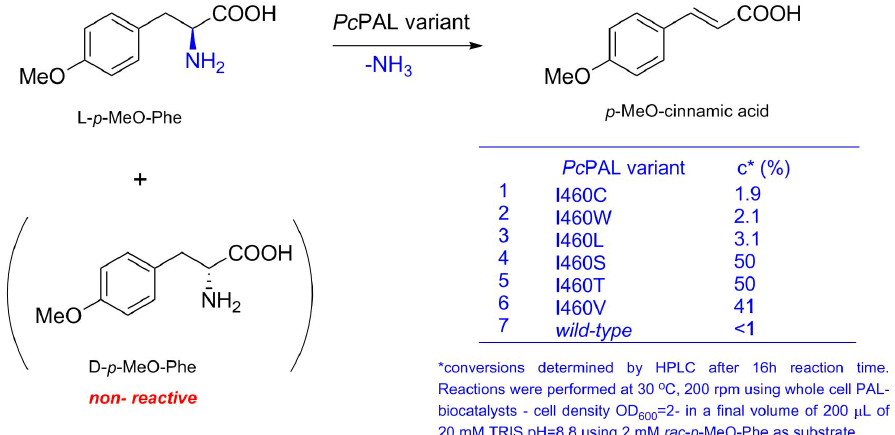
Figure 4. Ammonia elimination from racemic p -MeO-Phe using the induced whole-cells of the corresponding Pc PAL variants showing increased activity within the high-throughput activity screens.